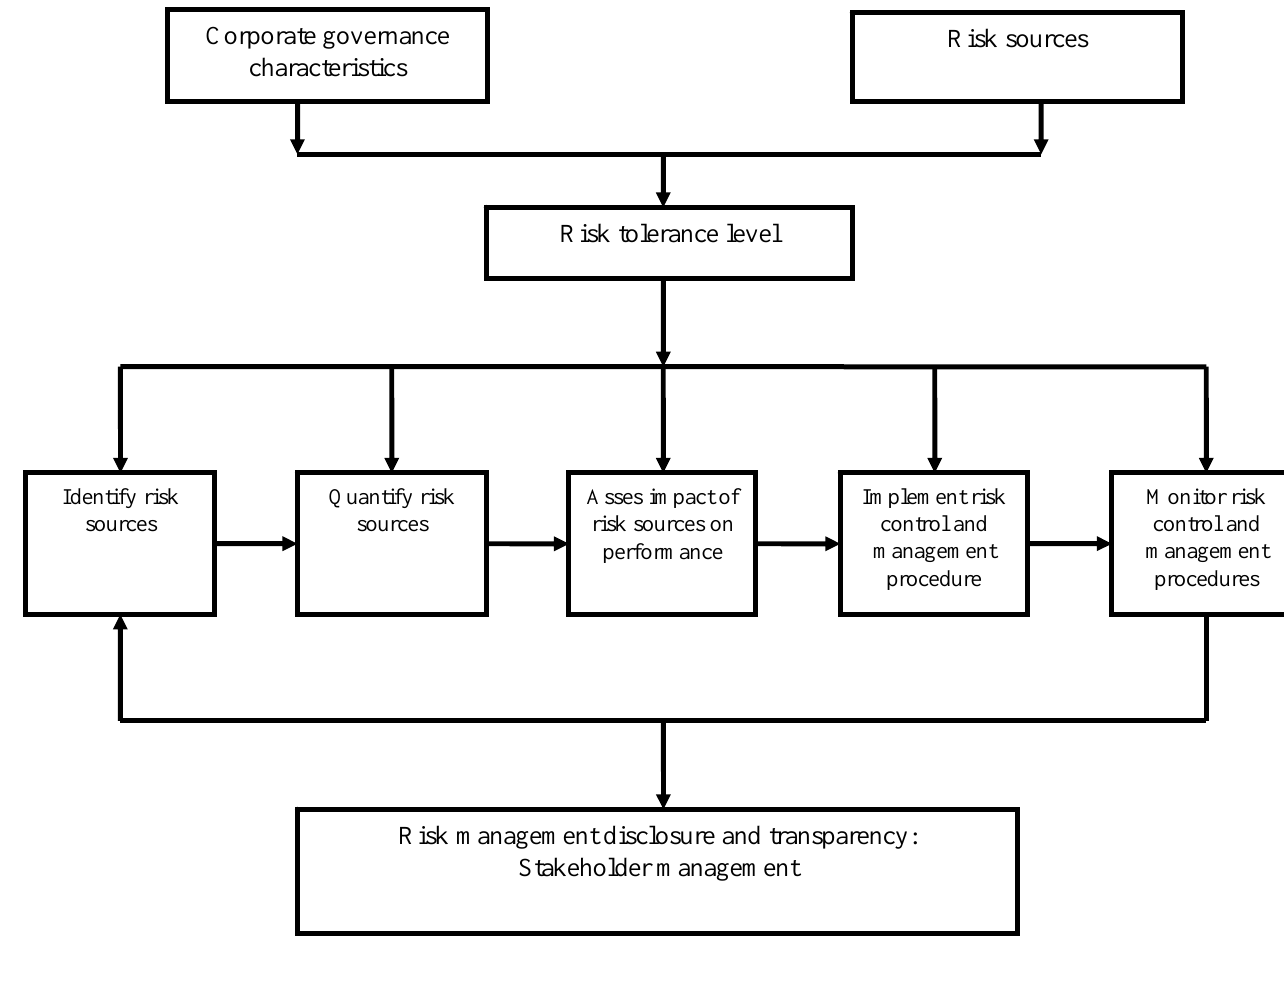
Figure 1: Corporate governance, risk management and